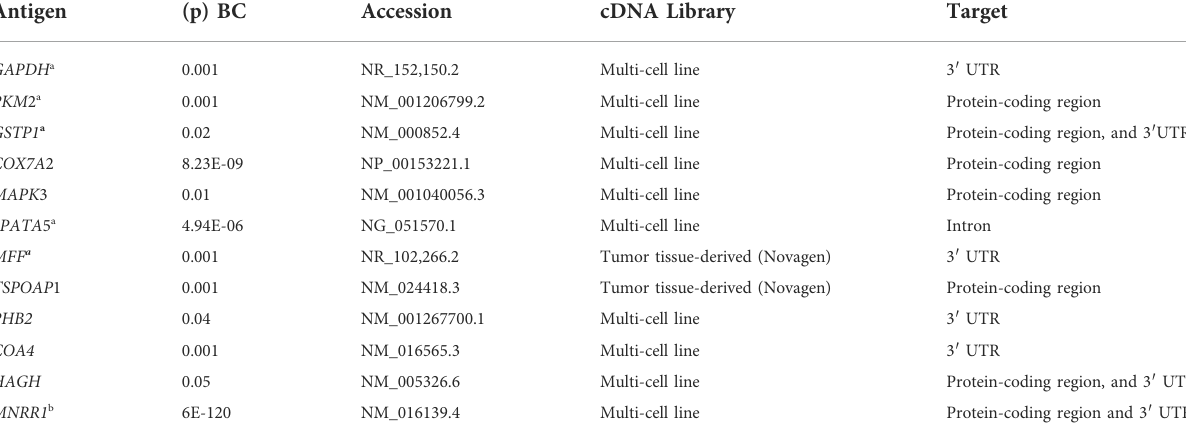
TABLE 1 NDNA-encoded mitochondrial autoantigens associated with the diagnosis of invasive breast